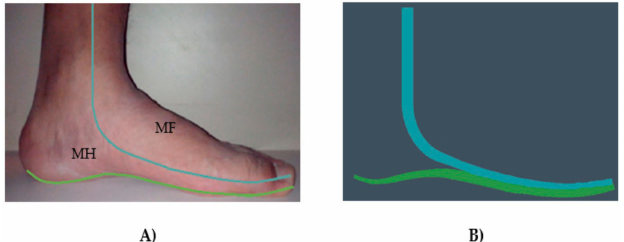
Figure 6. First prosthesis design. ( A ) Patient’s foot with respect to the sagittal plane. Module Foot (MF) and Module Heel (MH). ( B ) Geometric model of the customized